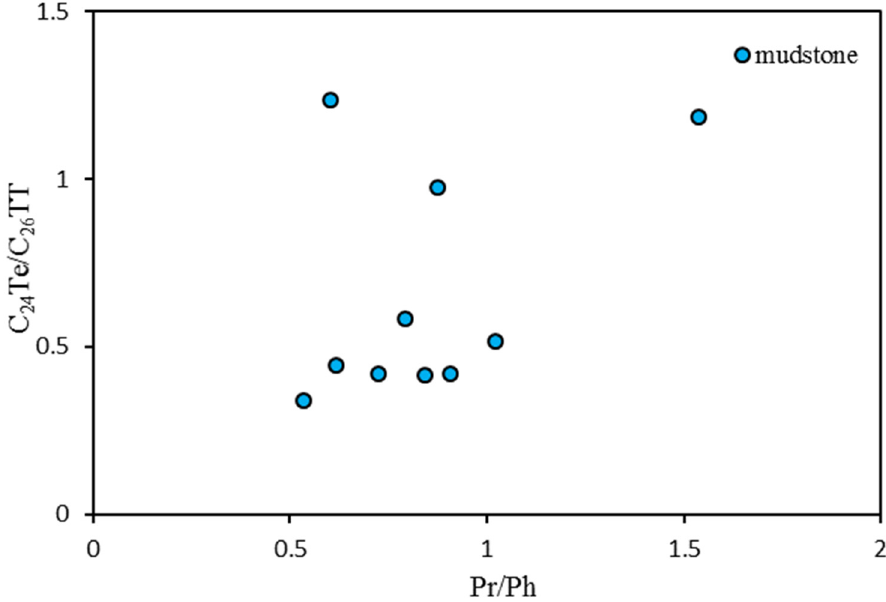
Figure 11. Relationship between C 24 Te/C 26 TT and Pr/Ph for coal ‐ measure source rock.